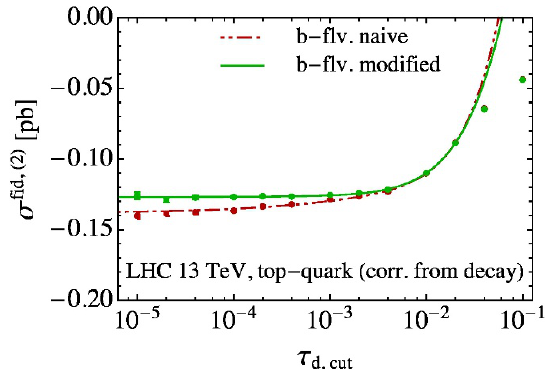
Figure 11 . NNLO correction from top-quark decay on the (cid:12)ducial cross section as a function of the cut-o(cid:11), for top-quark production at 13 TeV. Error bars represent a scan over di(cid:11)erent cut-o(cid:11) values. The curves show (cid:12)ts to the points in the small cut-o(cid:11) region for two di(cid:11)erent (cid:13)avor assignments. hard-scale choice is (cid:22) = (cid:22) = m with scale uncertainty evaluated by varying the two t R F together over the range 0 : 5 < (cid:22)=(cid:22) o <